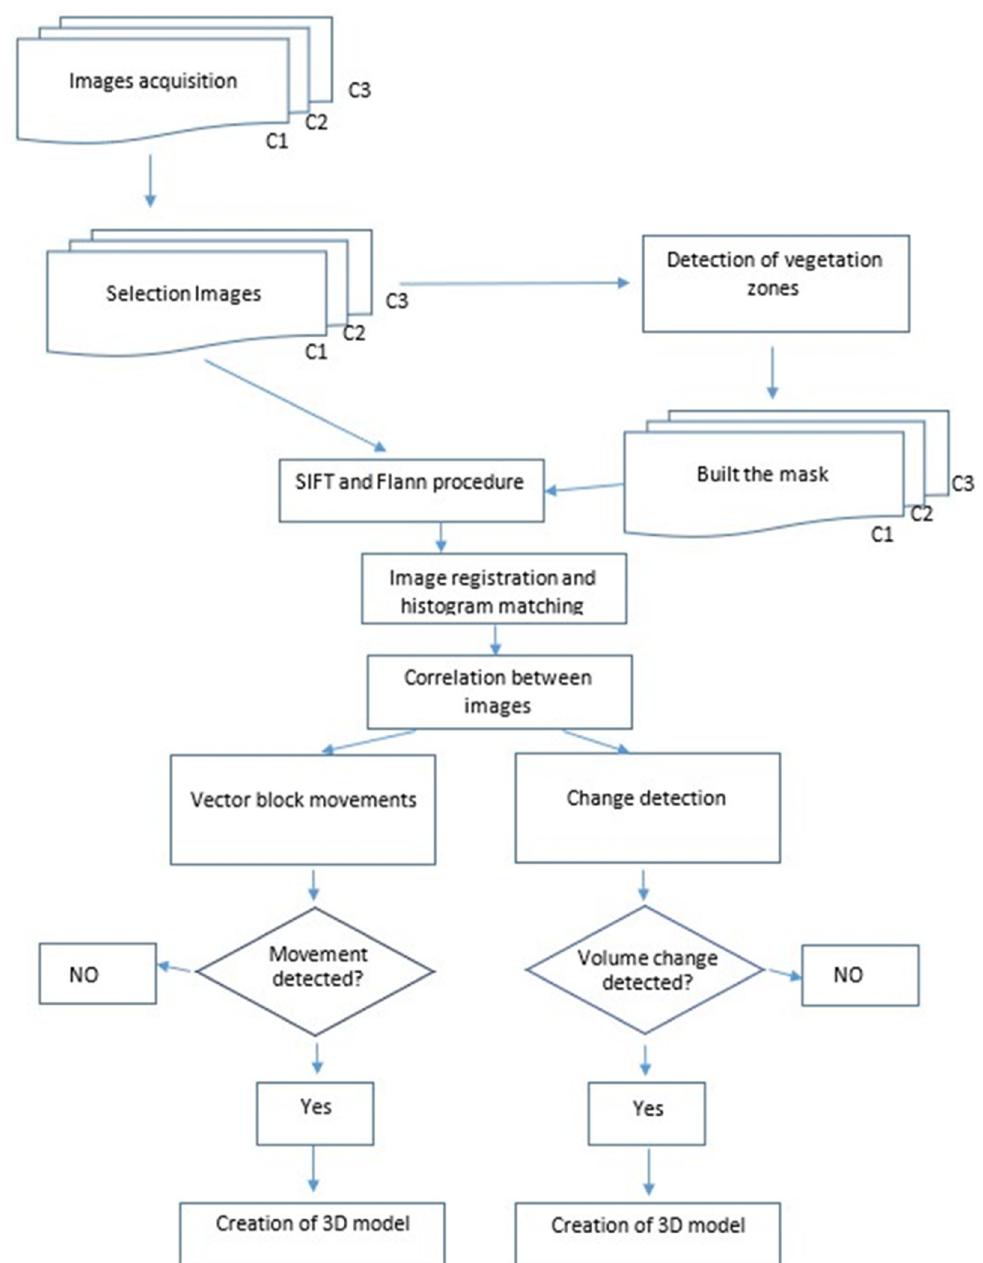
Figure 4. Flowchart of the process followed each day with the images.